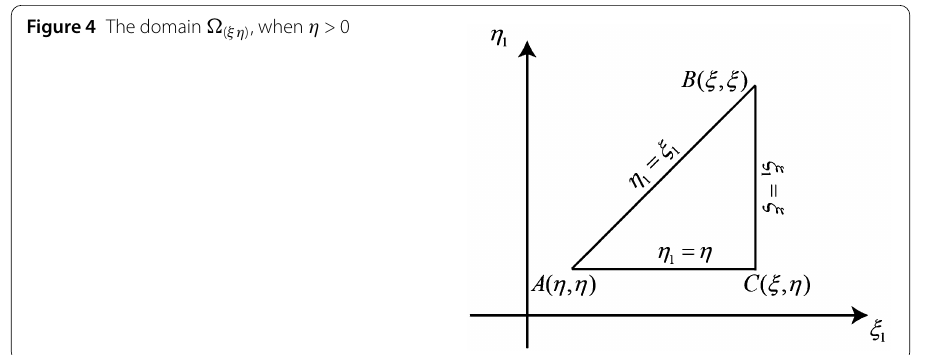
Figure 4 The domain (cid:10) ( ξη ) , when η >